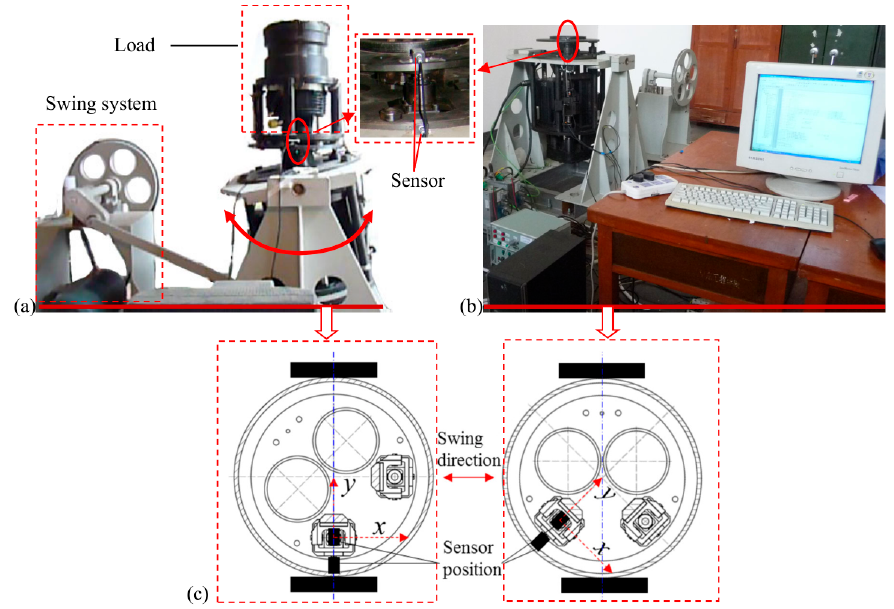
Figure 4. Ground simulation experiment system. ( a ) Experimental system setup: Swing system and attitude stabilization system. ( b ) attitude stabilization system and its control system. ( c ) Top view of attitude stabilization system and installation position of gyroscope sensor.